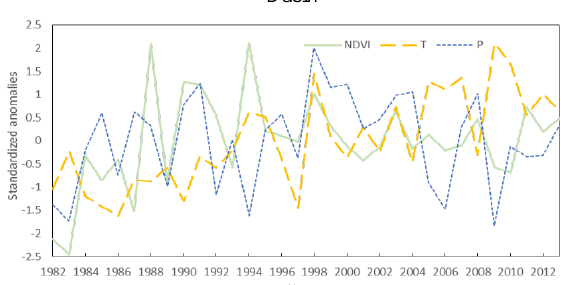
Figure 5. Trends in the mean NDVI and mean temperature and total precipitation in summer from 1982 to 2013